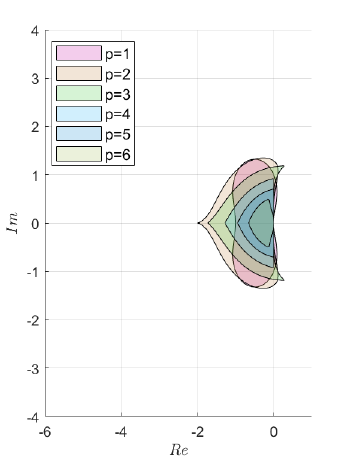
Figure 5. Stability regions of the Adams–Bashforth–Moulton predictor–corrector